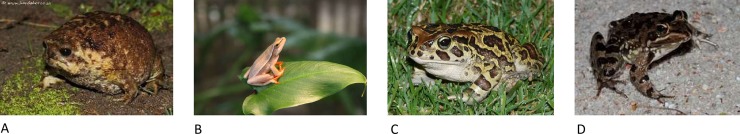
Flash-cards used to measure specific attitudes towards different frog types as would occur within the City of Cape Town.A: rain frog, Breviceps gibbosus. B: reed frog, Hyperolius horstockii. C: toad, Sclerophrys pantherina. D: river frog, Amietia fuscigula.